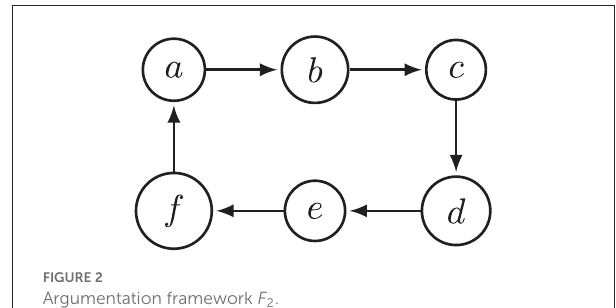
FIGURE2 Argumentation framework F 2